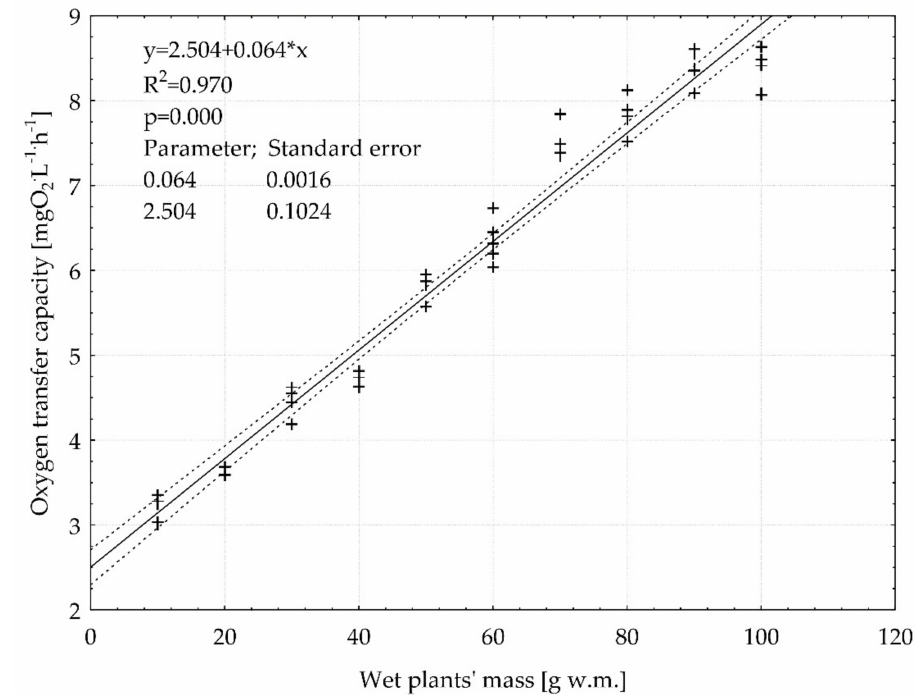
Figure 8. The correlation between oxygen transfer capacity (OTC) and wet plants mass. The parameters of linear regression analysis (regression coefficient, intercept, R 2 —determination coefficient, p—calculated probability, standard errors of regression coefficient and intercept) were given.